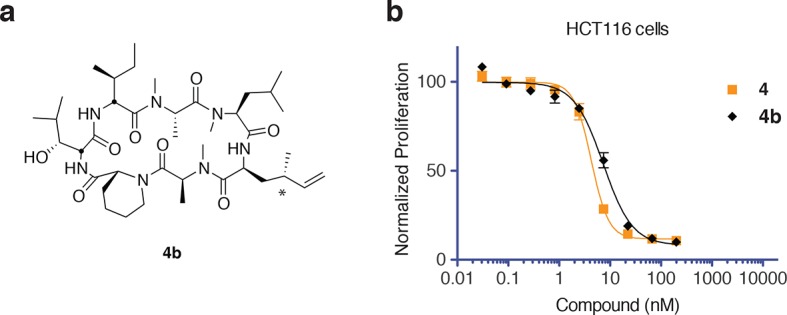
Epimers 4 and 4b have similar antiproliferative activity.(a) Chemical structure of 4b, containing (2S,4S)-dehydro-homoleucine. (b) Antiproliferative activity of 4 and epimer 4b toward HCT116 colorectal cancer cells (4b IC50 7.4 ± 1.3 nM).